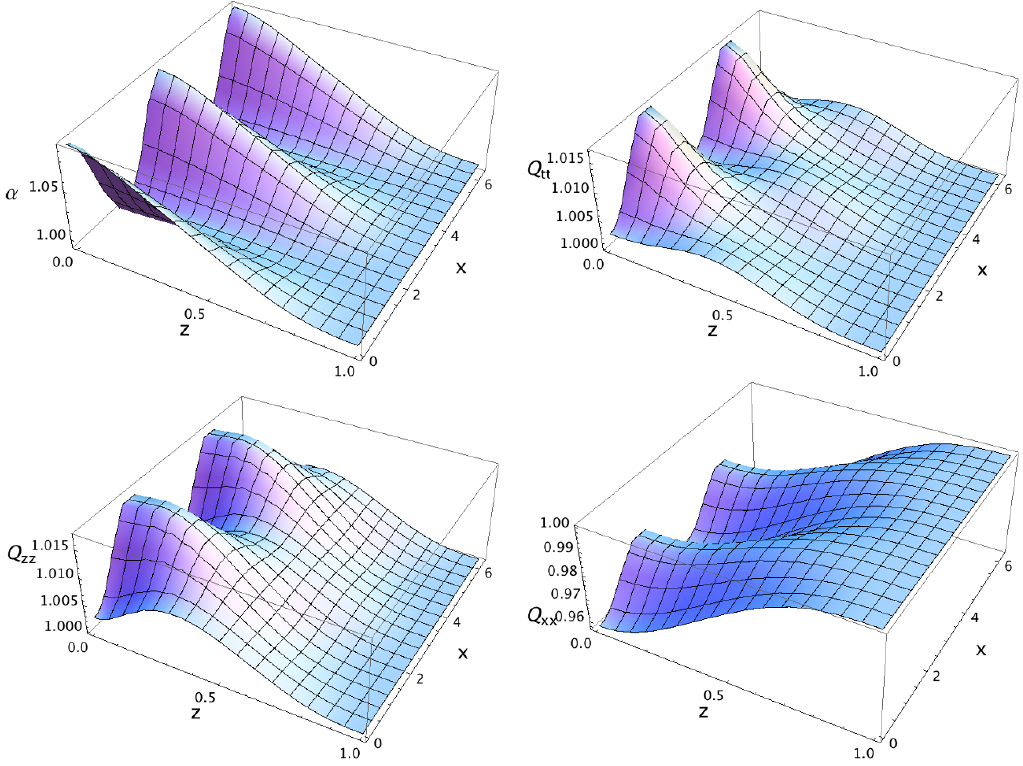
Figure 1 . Background con(cid:12)gurations for the gauge (cid:12)eld (cid:11) and metric (cid:12)elds Q tt ; Q zz ; Q xx at T = 0 : 01426 and k = 1, for the PDW phase without ionic lattice. The horizon is located at z = 0 and the AdS boundary at z = 1. We have set L = 1 =